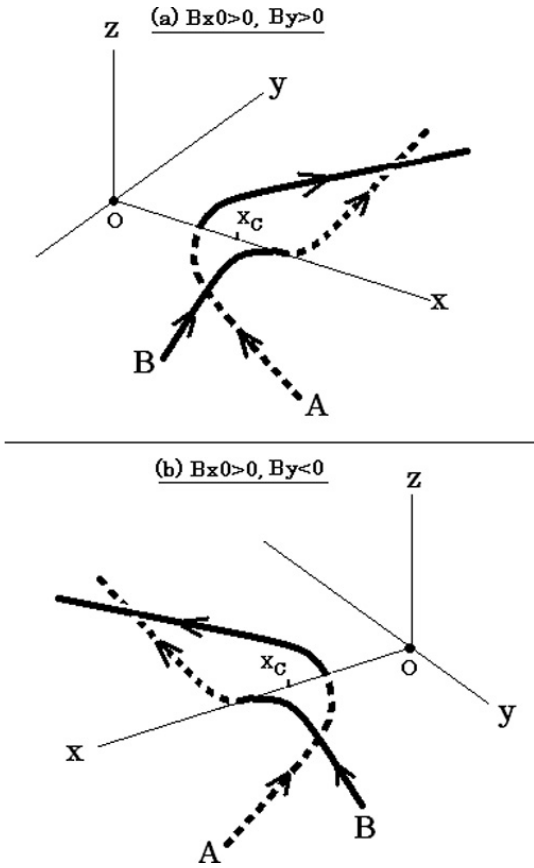
Fig. 11. Schematic drawings of the reconnected field lines, repre- sented by A , which pass through the x-axis in x <X C and the plas- moid reconnection region P, and the accumulated sheared field lines, represented by B , which pass through the x-axis in x > X C and the plasmoid core region C, where dotted lines indicate the field lines in z < 0, for the cases (a) B x0 > 0 ,B y > 0 and (b) B x0 > 0 ,B y < 0.